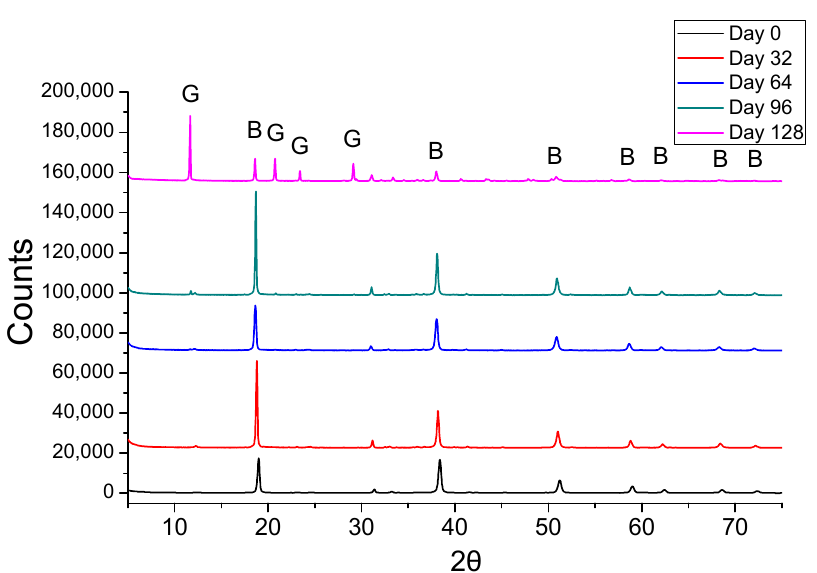
Figure 12. XRD overlay diffractograms of selected coated concrete specimens during the application of the 4-months acid spraying test; G: Gypsum, B: Brucite.